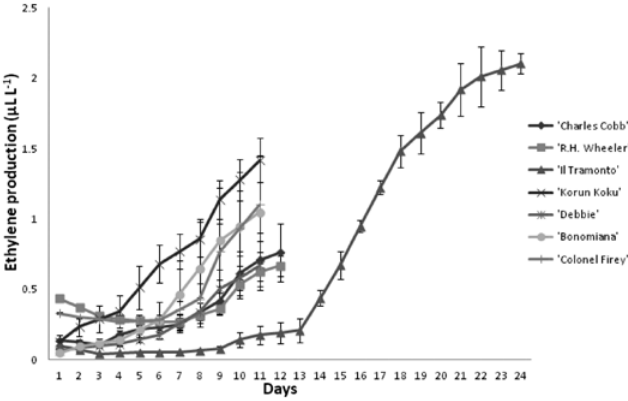
Fig. 3 - Mean values of the endogenous ethylene production in the studied cut flowering branches of Camellia japonica cultivars placed in tap